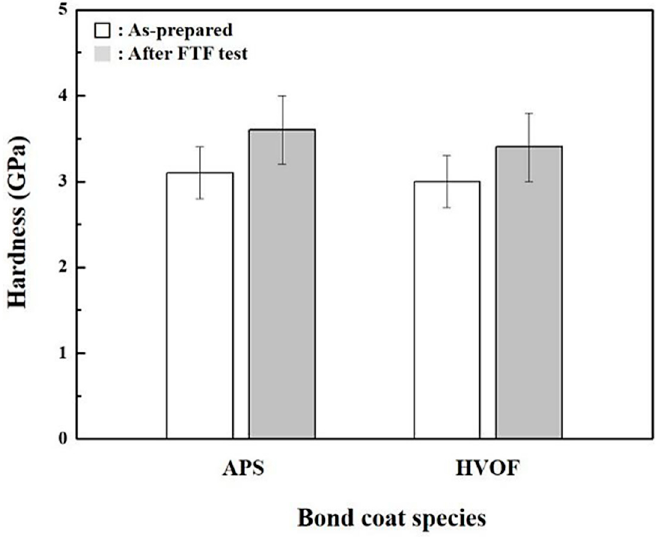
Figure 6. Hardness values of top coats before and after cyclic thermal exposure. Indentation for hardness was conducted on the sectional planes with a load of 3 N. Open and filled marks indicate the hardness values of top coats before and after FTF tests, respectively.